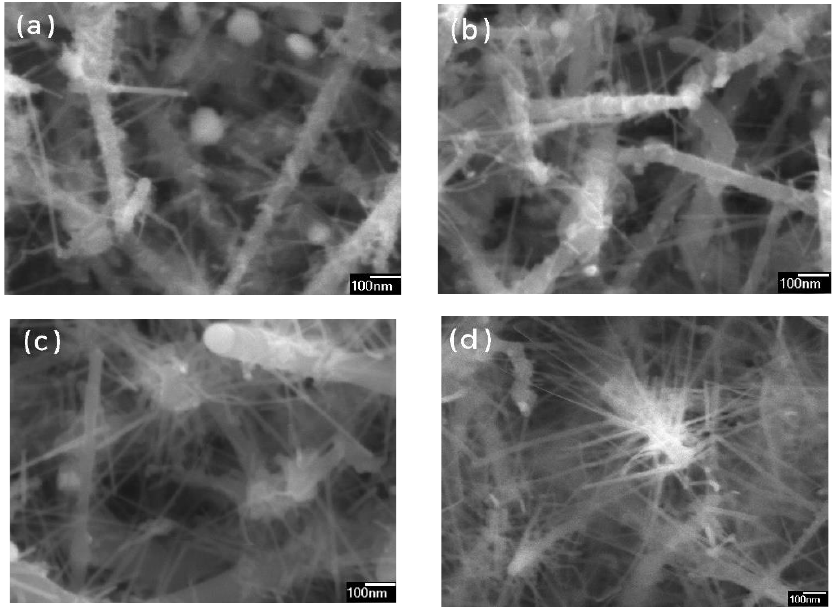
Figure 3. Samples were synthesized at 535 °C with different Silane shots number: ( a ) one shot, ( b ) two shots, ( c ) tree shots, and ( d ) four shots.